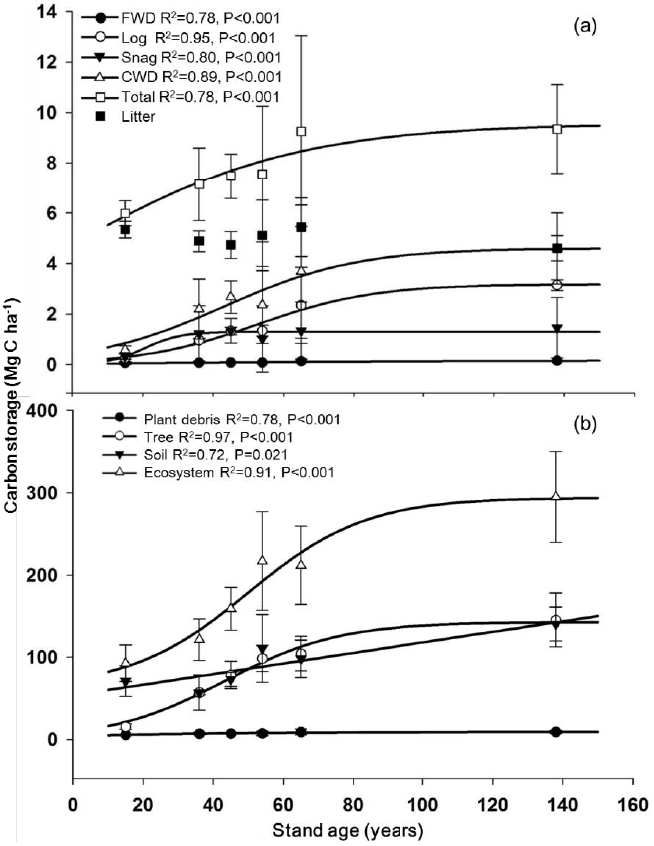
Figure 3. Carbon storage as a function of stand age for ( a ) plant debris and ( b ) ecosystem components.